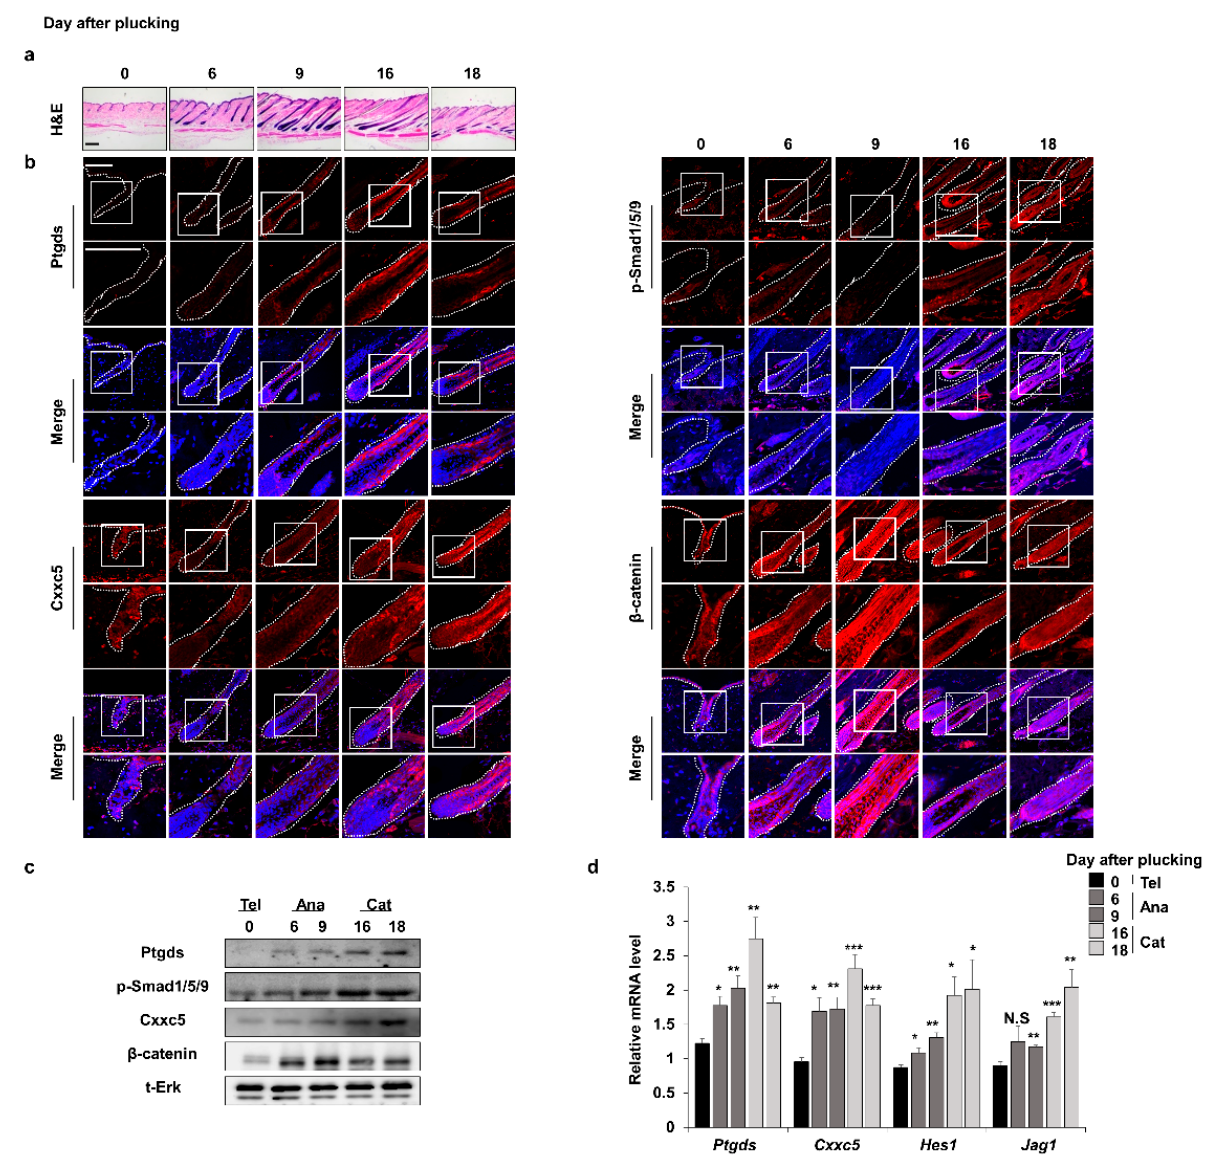
Figure 1. Expression profiles of factors related to hair growth during the depilation-induced hair cycle . The dorsal skins of C57BL/6N 7-week-old wild-type male mice were plucked and harvested